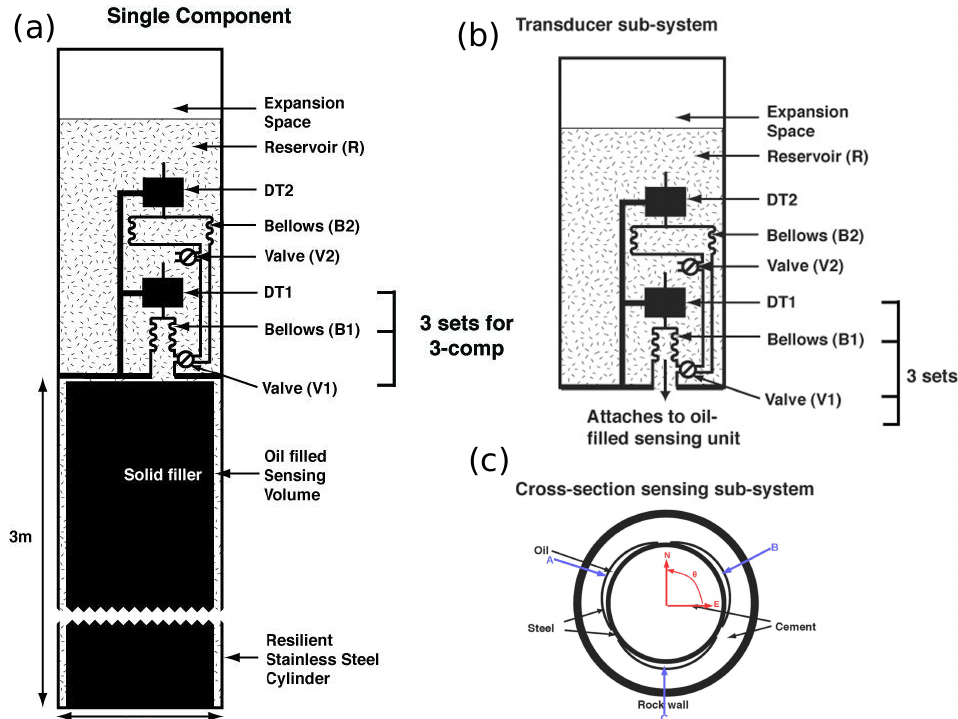
Figure 3. Design of a Sacks–Evertson borehole strainmeter: ( a ) dilatometer (single-component) and ( b ) 3-component strainmeter [21]. The 3-component design uses the same principle employed in the single-component instrument but incorporates three separate sensing volumes. Note that when valves V1 and V2 are closed, DT2 monitors volumetric changes of a fixed mass of oil that is decoupled from the strain field which thus represents a measure of the temperature at the installation depth (with resolution < 10 − 4 ◦ C). ( c ) Cross-section of a 3-component strainmeter. Gauges B and C are 120 ◦ clockwise and 120 ◦ counterclockwise from gauge A, respectively. The N-E axis reference for strain calculations is in